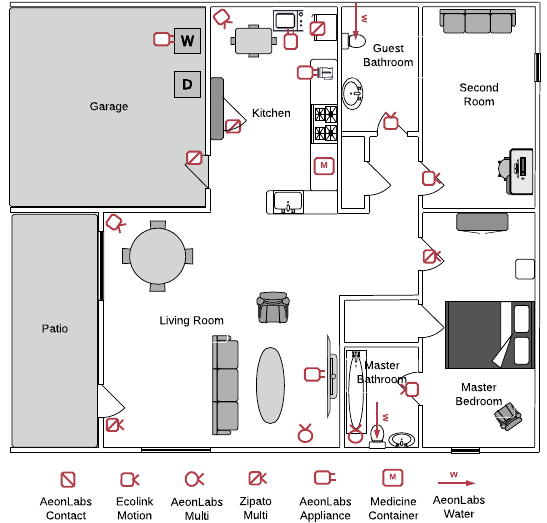
Figure 3. Sensor layout for a typical home in